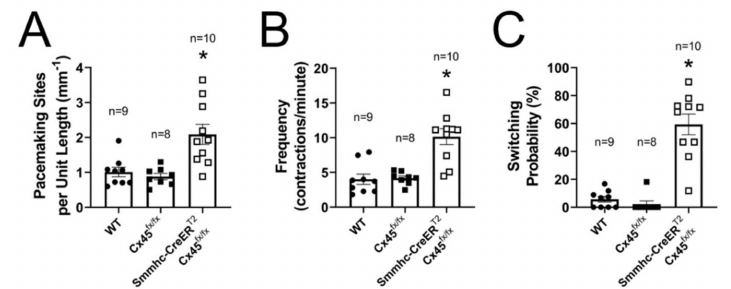
Figure 5. Summary analysis of the pacemaking activity in lymphatic vessels from control (C57BL / 6J WT and Cx45 fx / fx ) and LMC Cx45-deficient (Smmhc-CreER T2 ;Cx45 fx / fx ) mice under control intraluminal pressure (P upstream = P downstream = 2 cmH 2 O): ( A ) Number of pacemaking sites per unit length; ( B ) Pacemaking frequency (frequency of contractions); and ( C ) Calculated pacemaking switching probability. * Indicates statistical significance ( p < 0.05) when compared to all other unmarked